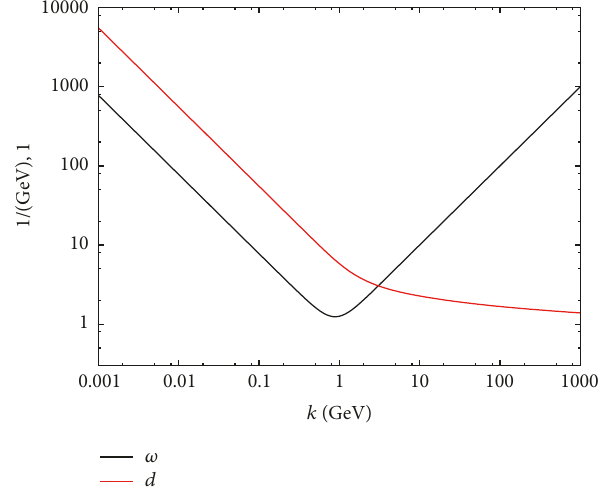
Figure 2: Numerical solution of the coupled gap equation for 𝜔 (10) and Dyson–Schwinger equation for the ghost form factor 𝑑 (13) for the renormalization constant 𝑐 = 0 for 𝑑 = 3 spatial dimensions [25]. The scale is fixed by the Coulomb string tension; see Section